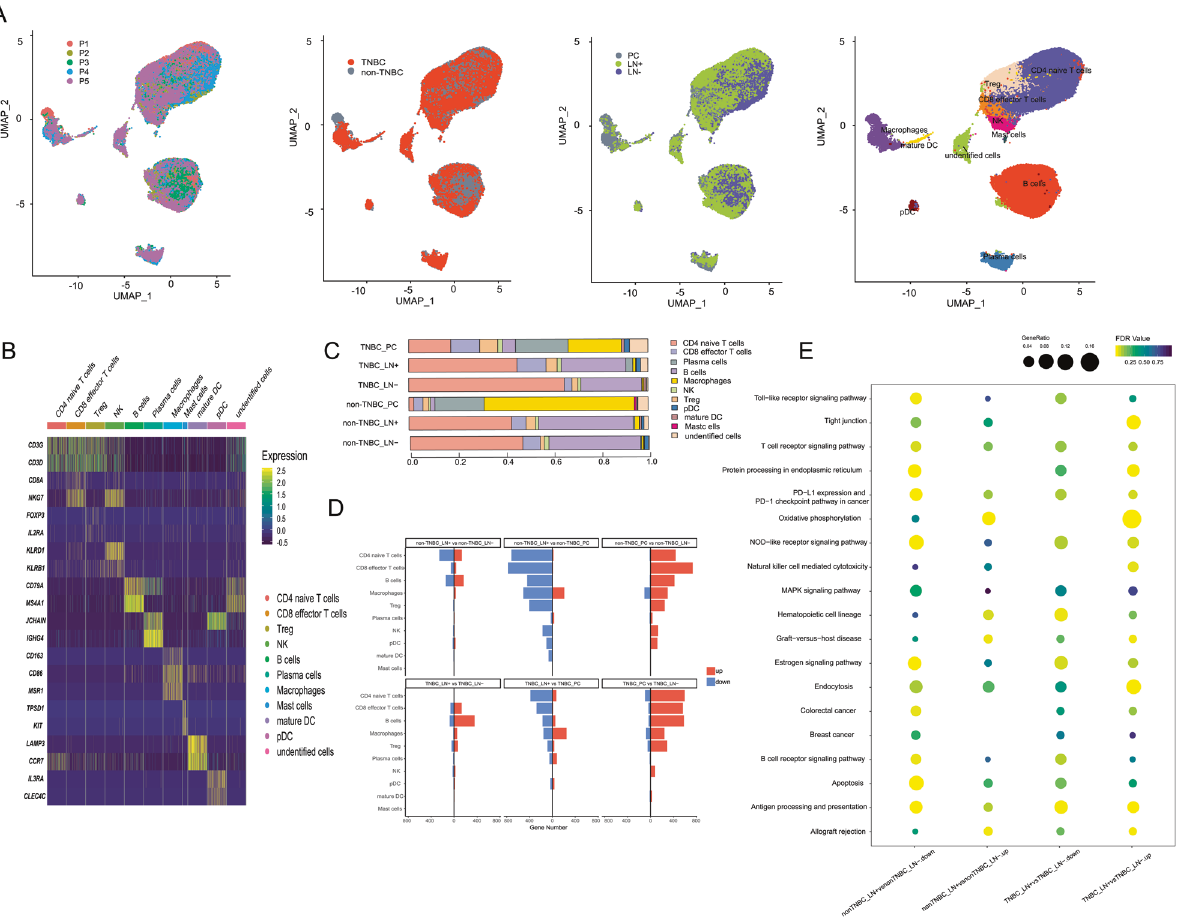
Fig. 5 Transcriptome characterization of immune cells surrounding breast cancer cells. A UMAP plots of all immune cells from fi ve primary tumors and ten paired axillary lymph nodes, colored according to cell types, patients, molecular subtypes, and sample origins. B Heatmap showing expression levels of known cell-type-speci fi c markers. Colors represent cell types as in. C Immune cell composition of samples according to molecular subtypes and tumor origin. D Bar plots showing comparisons of sample origins in terms of gene numbers. E Functional enrichment of transcriptome differentiation across sample origins. (PC, primary tumor; LN + , lymph nodes with cancer cells; LN-, lymph nodes without cancer